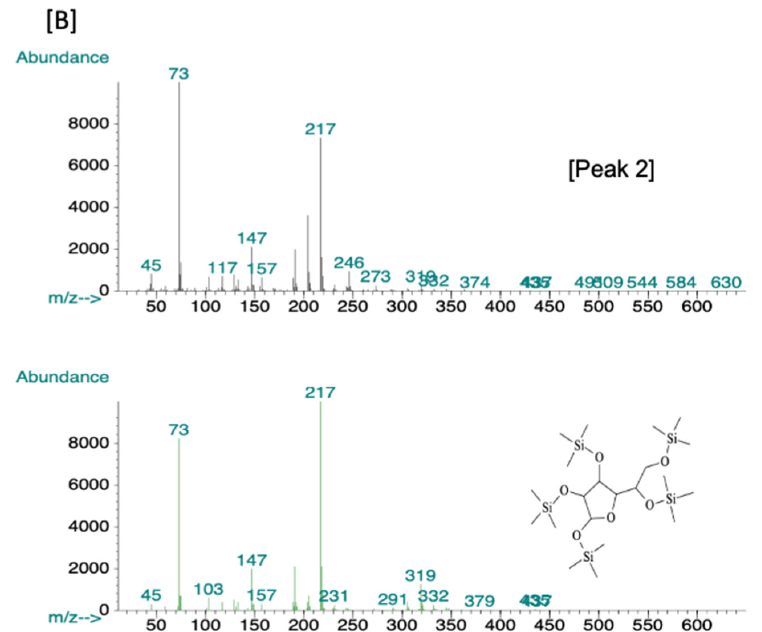
Figure 6. GC-MS spectrum of peak 1 and 2 selected from GC-MS chromatogram and compared with the library of mass spectra stored in the Chemstation database of MS. Comparison showed that peak 1 is 91% similar to D-ribose [ A ], and peak 2 is 80% similar to β - D -galactofuranose [ B ].